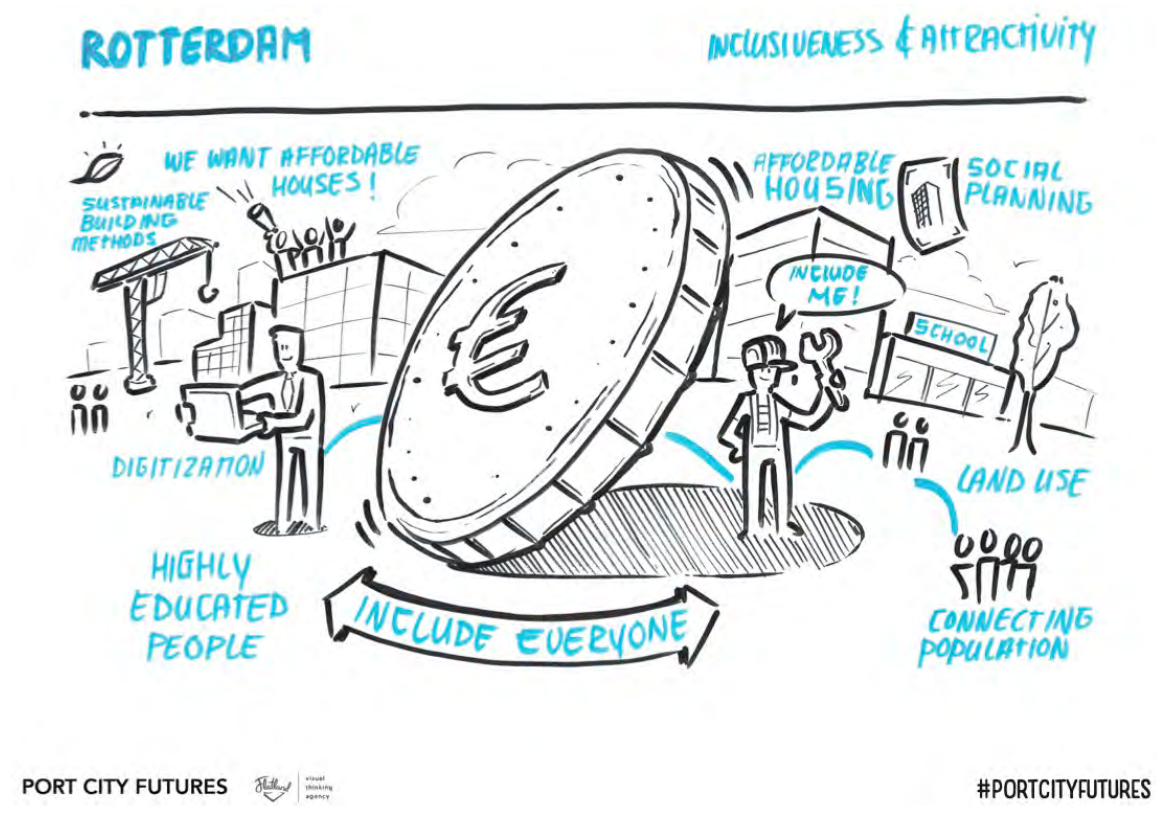
Visual report of a value deliberation process during the first PortCityFutures conference in December 2018. Made by Flatland Visual Thinking Agency for